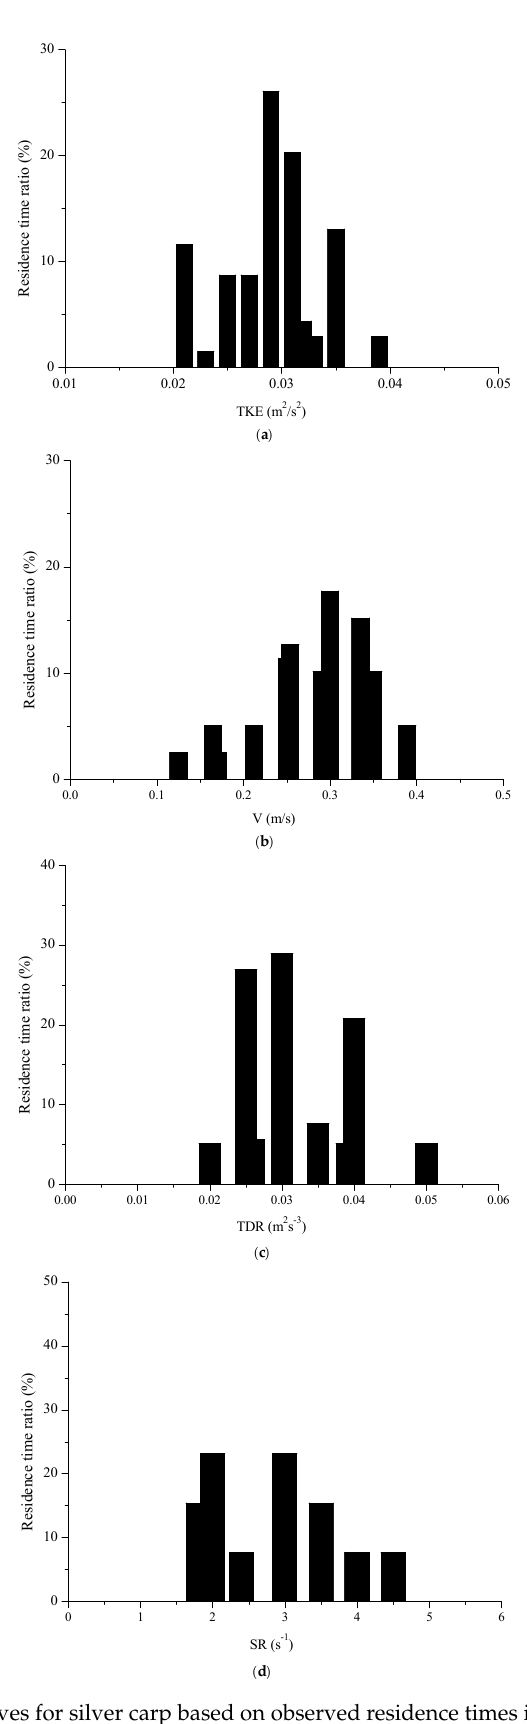
Figure 4. Hydraulic curves for silver carp based on observed residence times in the experimental VSF: ( a ) TKE; ( b ) V; ( c ) TDR; ( d ) SR.